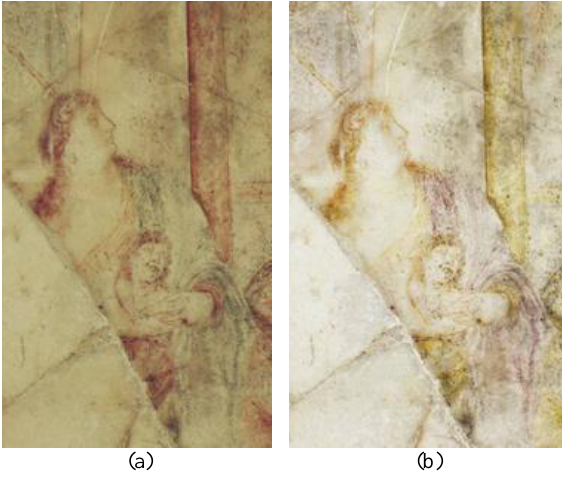
Figure 1. Example of Ultraviolet False Color (UVFC) imaging technique. (a) VIS image and (b) UVFC image